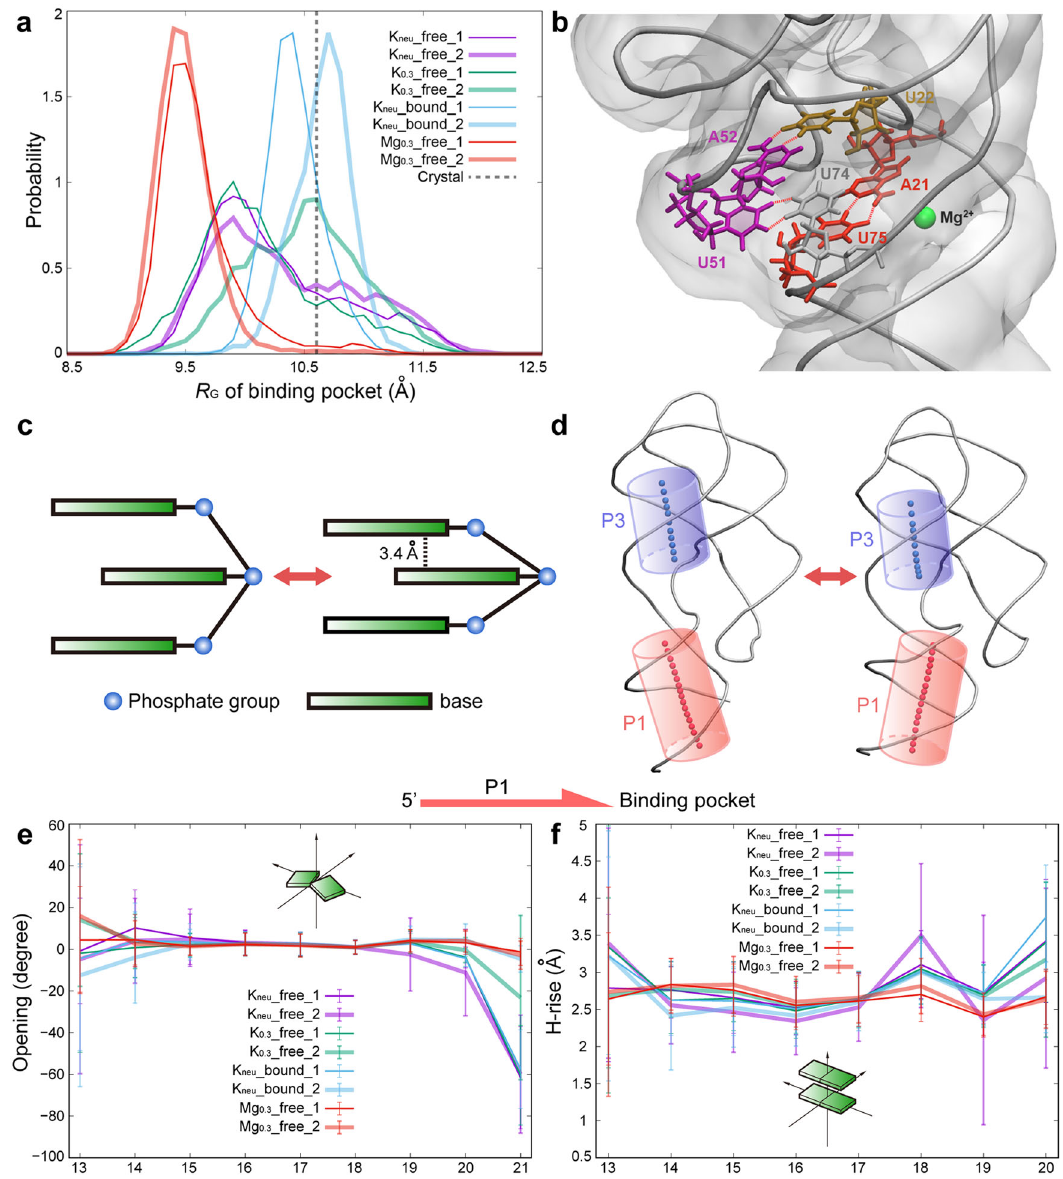
Fig. 7 The structural changes around ligand binding pocket and their impacts on other regions of AARA. a The normalized distributions of R G of binding pocket for all eight simulation trajectories, and the gray dashed line corresponds to R G of binding pocket in the crystal structure (~10.6 Å). b The structure of ligand binding pocket in Mg 0.3 _free system (taking Mg 0.3 _free_1 as an example), and the hydrogen bond interactions between important residues near binding pocket are indicated by red dashed lines. An important Mg 2 + ion binding site (represented by green sphere) in this state is also marked in the fi gure. c A schematic diagram of change in base stacking structure caused by the bending deformation of the backbone at C J12-P1 . d The change of coaxial stacking morphology between P1 and P3 caused by the deformation of C J12-P1 . The central axes of P1 (red) and P3 (blue) are drawn with the van der Waals representation of hydrogen atom. The average values and standard deviations of Opening ( e ) and H-rise ( f ) of each base pair in P1 helix for all eight simulation trajectories, and the direction of P1 (from 5 ’ end to binding pocket) is also shown in the fi